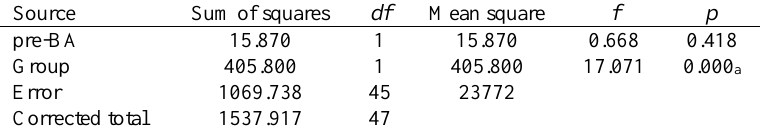
Table 2 Post-BA ANCOVA results between the students in Mbio and TCbio groups